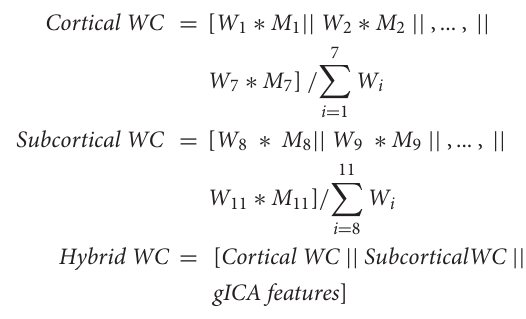
ROIs acquired from the DKT and DKD_ Desai_PM